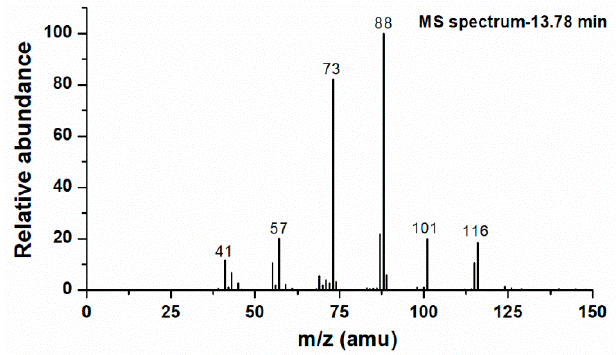
Figure 5. Mass spectra corresponding to the chromatographic peak at 13.78 min.